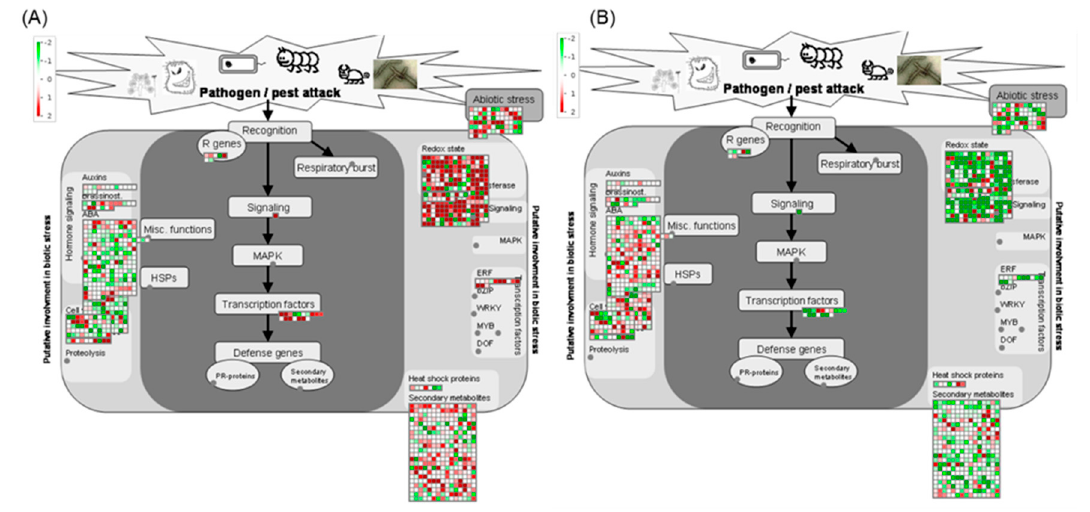
Figure 5. MapMan pathway analysis shows the expression of genes in biotic and abiotic stress-related pathways between the genotypes ( A ) PI 257145 and ( B ) PI 224448.